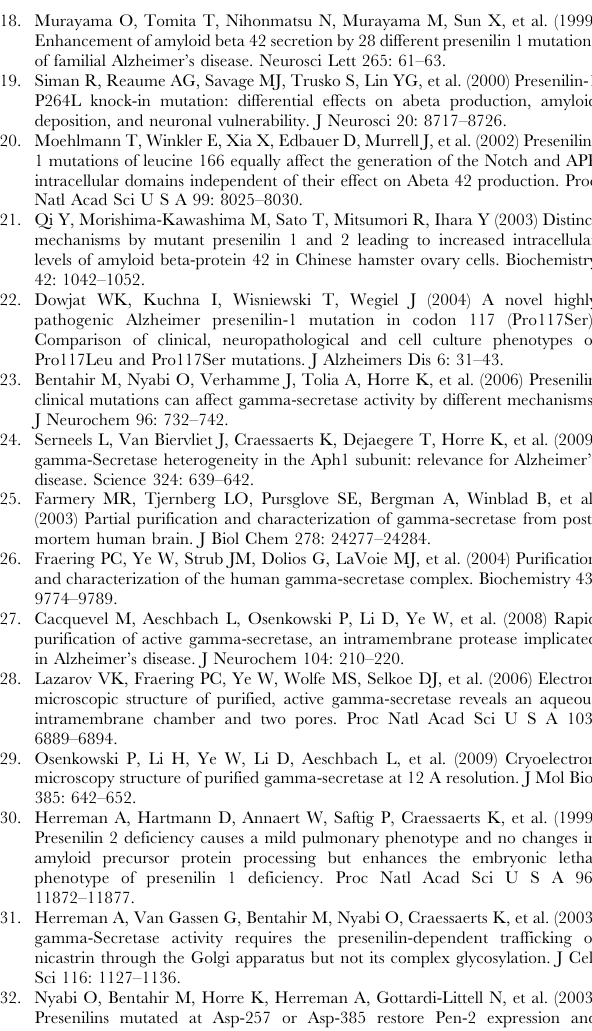
Figure S3 APH1 isoforms expressed in MEF PS1/2 2 / 2 .